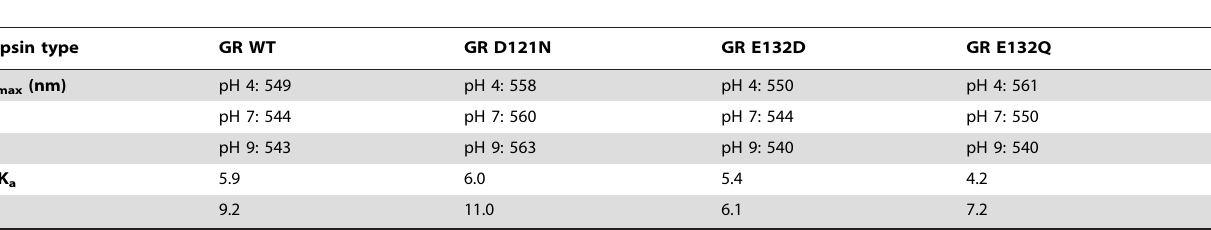
Table 1. Absorption maximum and pK a value of wild-type and various GR